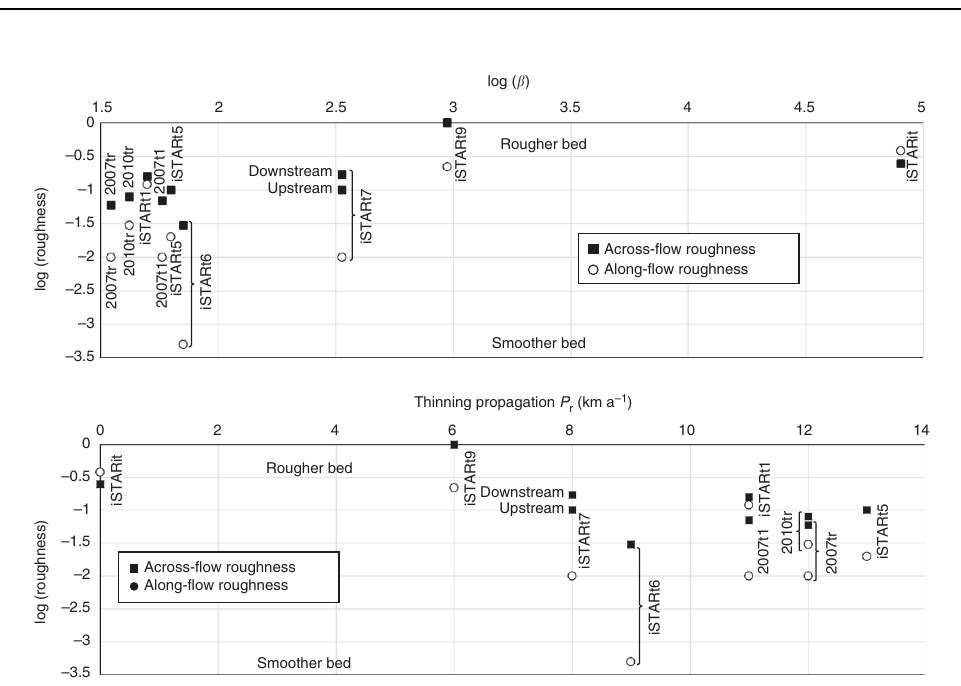
Fig. 3 In fl uence of bed roughness on inverted basal traction and inland propagation of ice-stream thinning. Table 1 caption describes the derivation of basal traction β and inland propagation of thinning P r . Basal roughness has been measured across and along fl ow at each patch in 2-km moving windows. In all cases except site iSTARit, the along- fl ow pro fi les are smoother than across- fl ow pro fi les, as expected in locations of